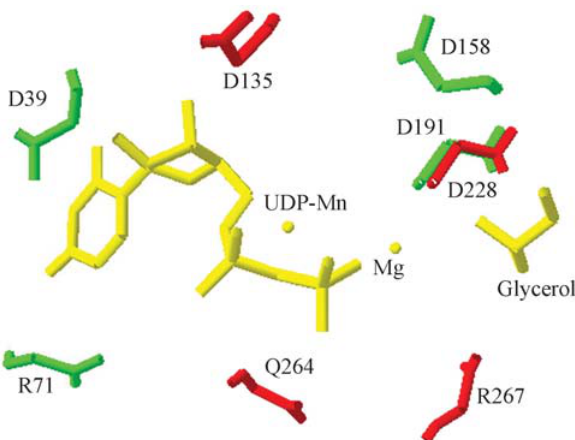
Figure 2 - Superimposed proteins closing up the active site of SpsA pro- tein bound to Mn-UDP with the built model of HmsR protein C. violaceum . The residues of SpsA are green with HmsR residues in red and the UDP-Mn, Mg and Glycerol in yellow.